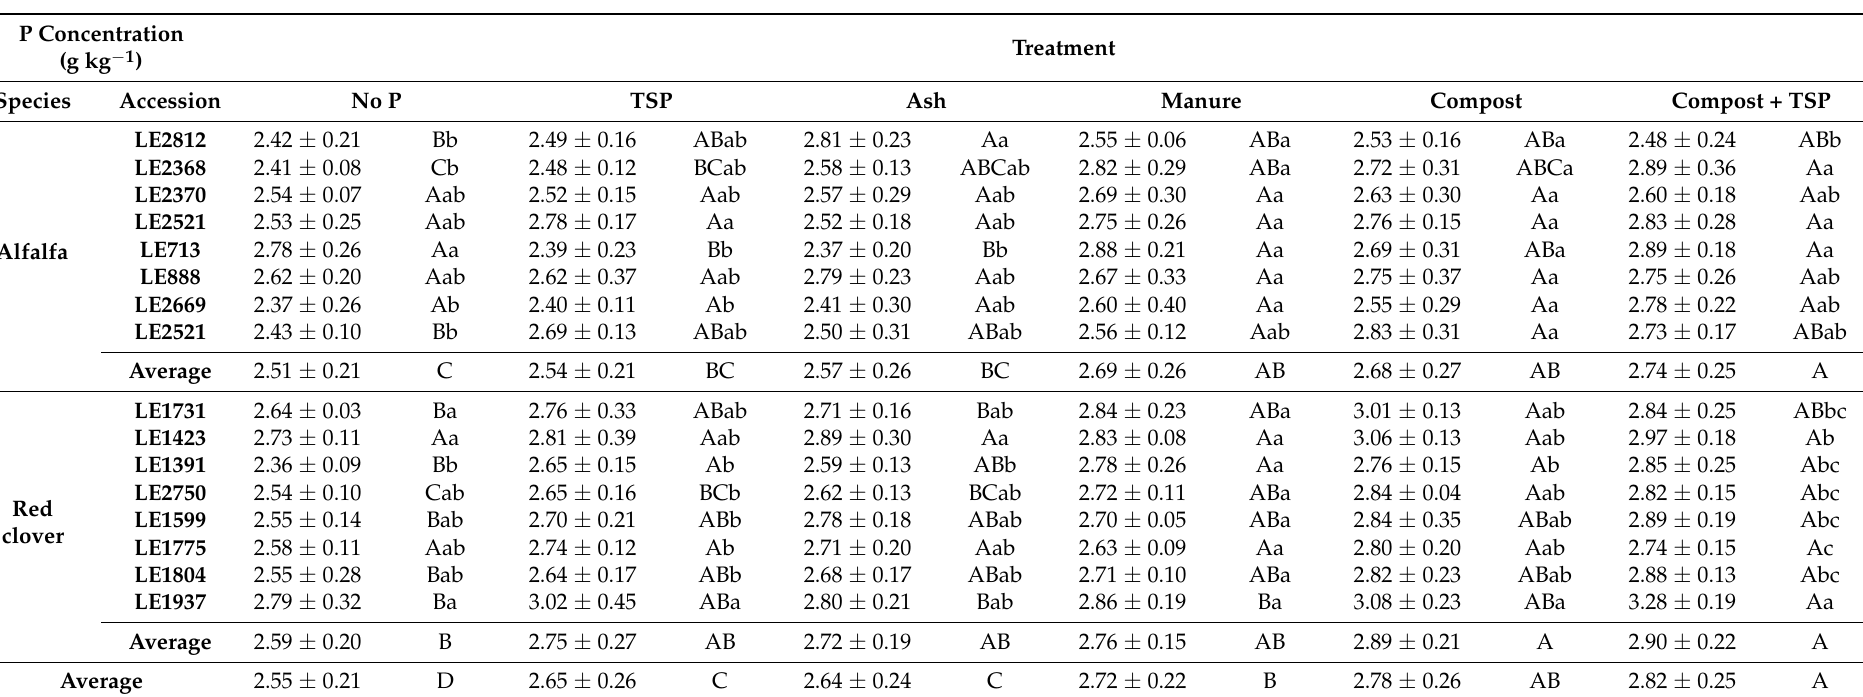
Table 4. Phosphorus (P) concentration of selected accessions of alfalfa and red clover from the six studied treatments (no P, TSP, ash, manure, compost, and compost + TSP) in